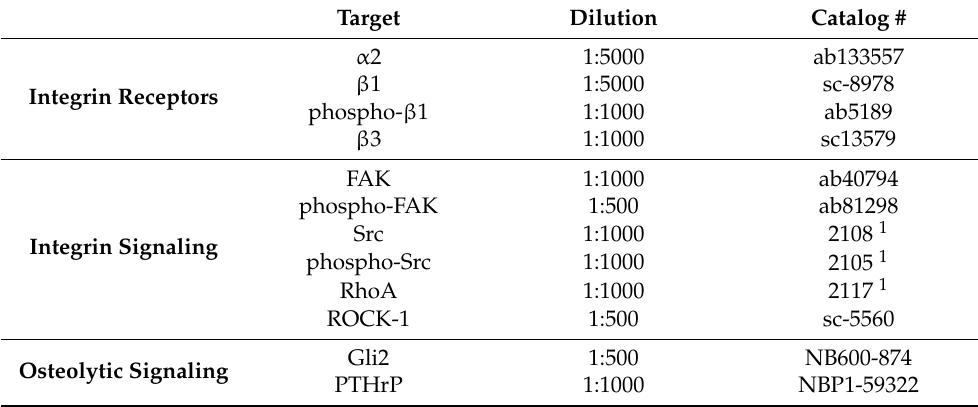
Table 1. Primary antibodies used for western blot